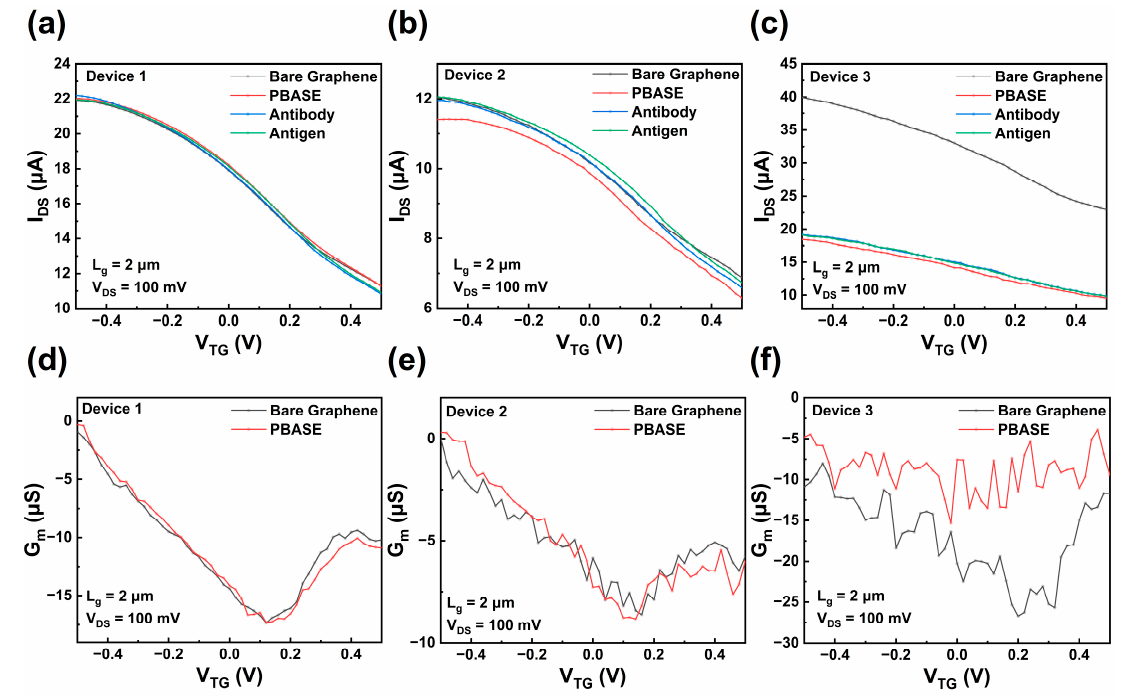
Figure 5. Electrical measurements of prepared SGFET biosensors. ( a – c ): The transfer curves of three SGFET biosensors labeled as “Device 1”, “Device 2”, and “Device 3”, respectively. I DS : drain–source channel current. ( d – f ): The transconductance ( G m ) curves as a function of V TG for Device 1, Device 2, and Device 3, respectively. The labels “Bare Graphene”, “PBASE”, “Antibody”, and “Antigen” refer to the unmodified graphene device, the graphene device after PBASE adsorption, the graphene device after SARS-CoV-2 antibody immobilization, and the graphene device after SARS-CoV-2 antigen detection, respectively. In all electrical measurements, the V DS of the devices was always maintained at 100 mV. Device 1, Device 2, and Device 3 have the same channel length ( L g , 2 µ m ) and channel width (20 µ m